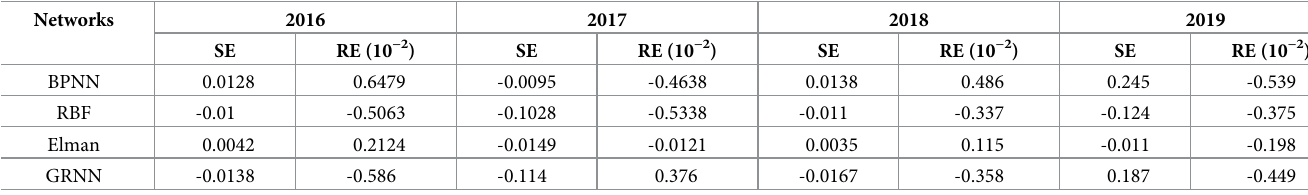
Table 1. Performance evaluation of different carbon emission prediction